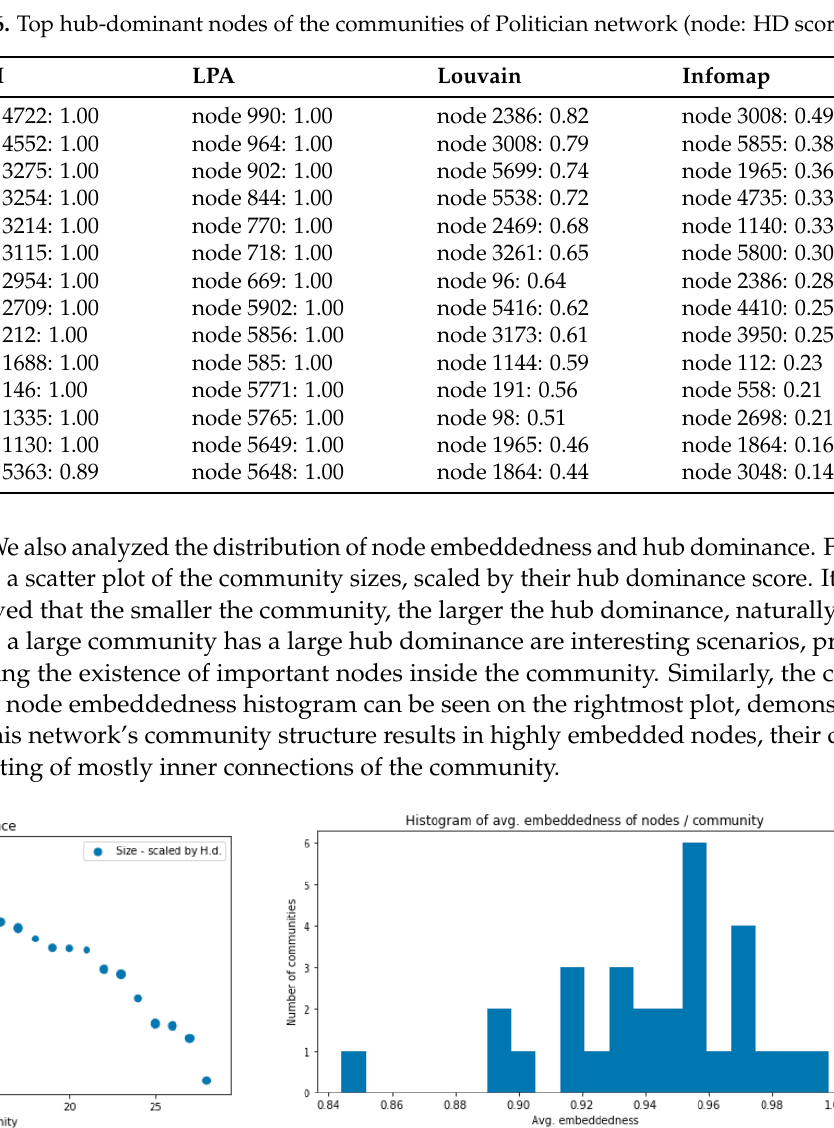
Figure 5. Politicians network: community sizes scaled by their hub dominance score, and histogram of node